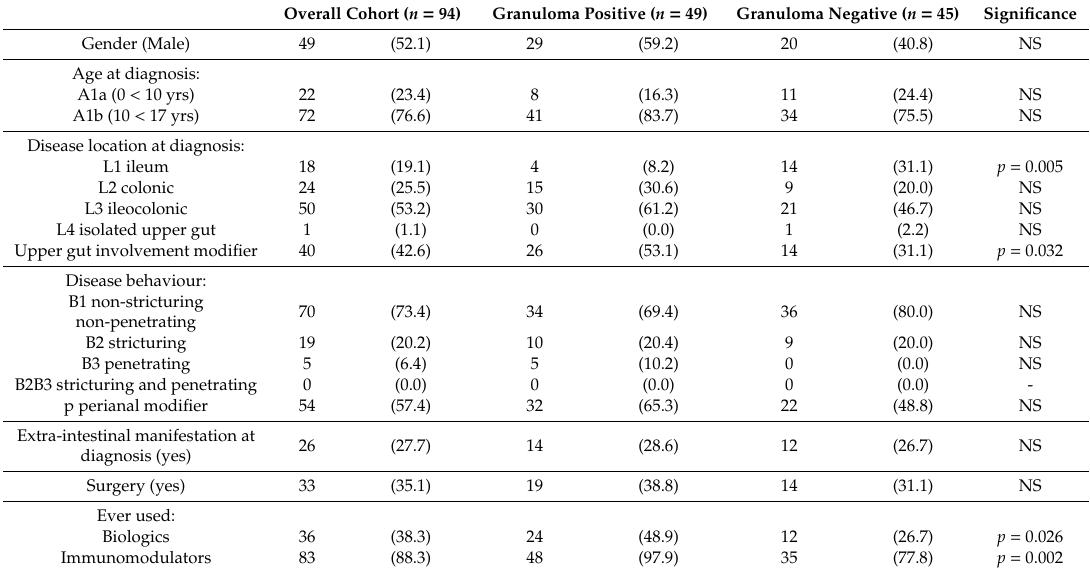
Table 1. Demographic and phenotype characterization for population of 94 children with Crohn’s disease, according to the presence or absence of granulomata. NS = not